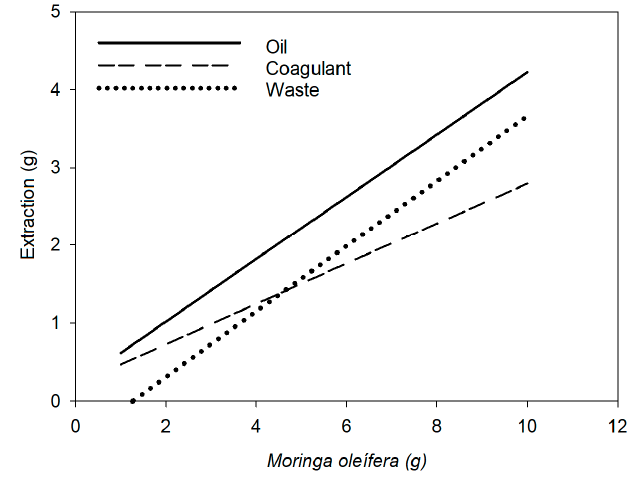
Figure 2. Linearity of the oil content (g) and biomass of Moringa oleifera .